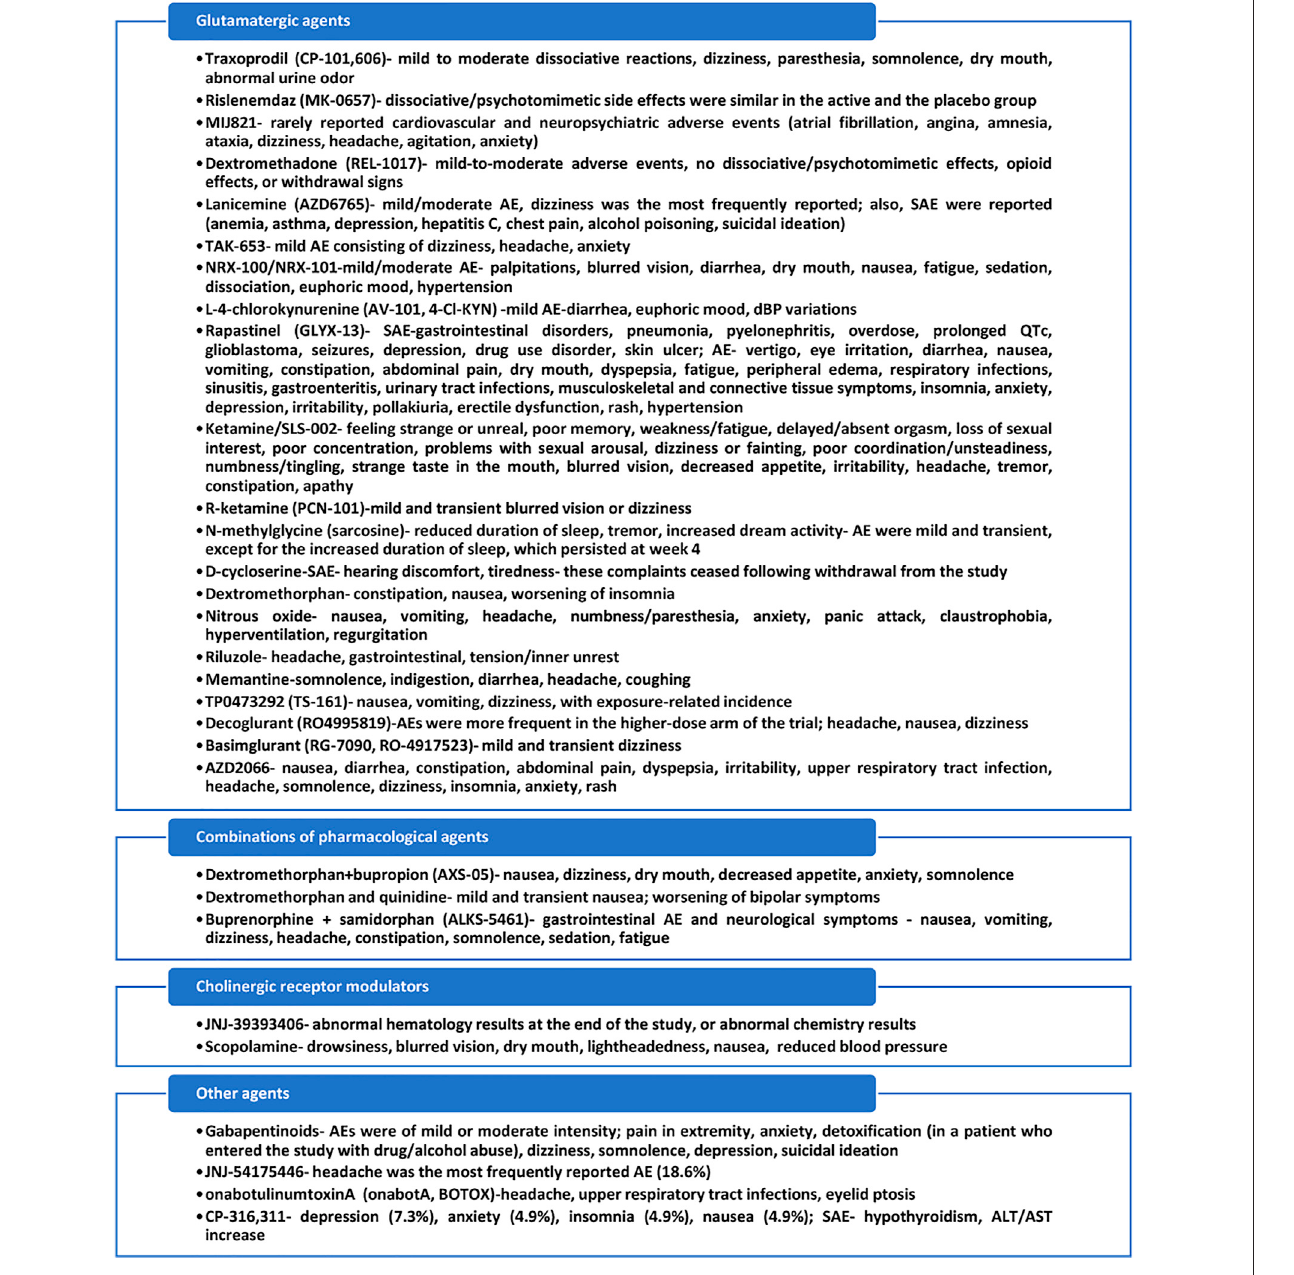
Frontiers in Pharmacology |